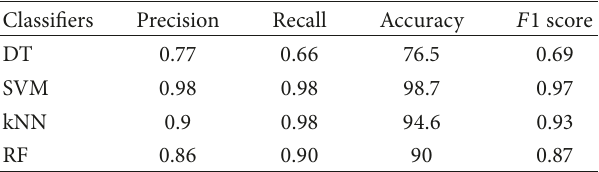
Table 2: Fuel system